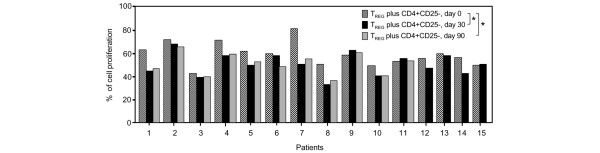
Rituximab effect on the suppressive function of T regulatory (TREG) cells in patients with systemic lupus erythematosus. CD4+CD25+ T cells were isolated and then mixed or not with autologous CD4+CD25- lymphocytes in the presence of phytohemagglutinin, and cultured for 72 hours. Then, cell proliferation was determined by 3H-methyl-thymidine incorporation. These assays were performed before (day 0), and at days 30 and 90 of Rituximab therapy, as described in Materials and methods. All experiments were run in triplicate, and the results expressed as the percent of cell proliferation (CD4+CD25- lymphocytes cultured without CD4+CD25+ cells = 100%). * p < 0.05